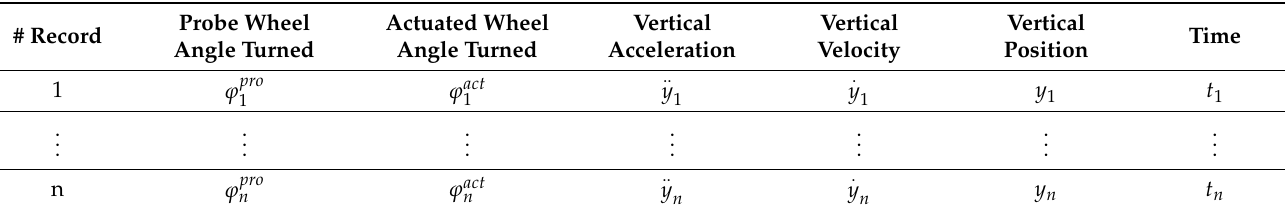
Table 3. Database of recorded and computed values.